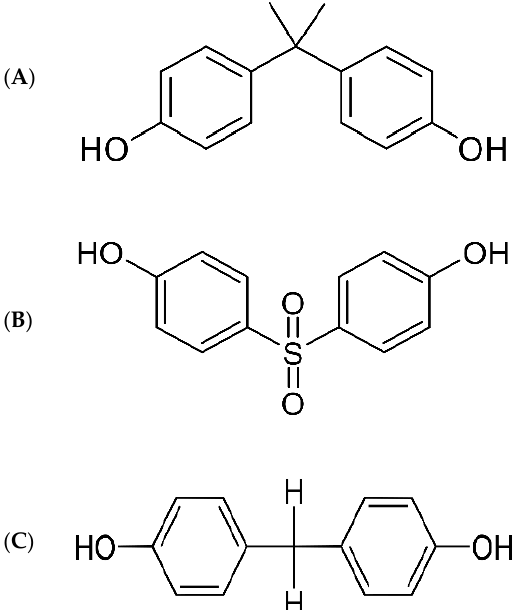
Figure 1. Chemical structures of bisphenol A ( A ), bisphenol S ( B ), and bisphenol F ( C ).